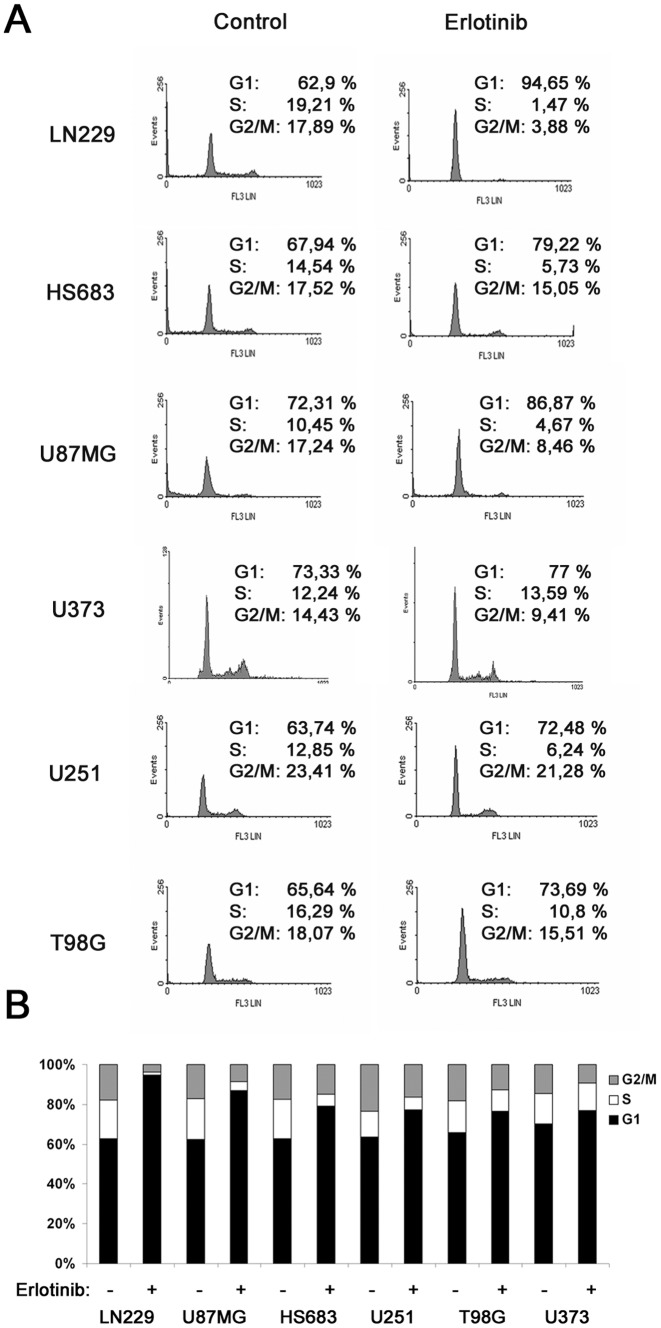
Erlotinib prevents multicellular tumour spheroid formation and induces G1 arrest in glioma cells.(A) Glioma cell lines were left untreated (control) or were treated for 24 h with 10 µM erlotinib (erlotinib). Cells were harvested and their DNA content analyzed by flow cytometry as described in Materials and Methods. The cell cycle distribution is shown for each experimental condition. (B) The graph summarizes the flow cytometry data obtained in all glioma cell lines, indicating the cell cycle distribution in control and 24 h erlotinib-treated conditions for each cell line.